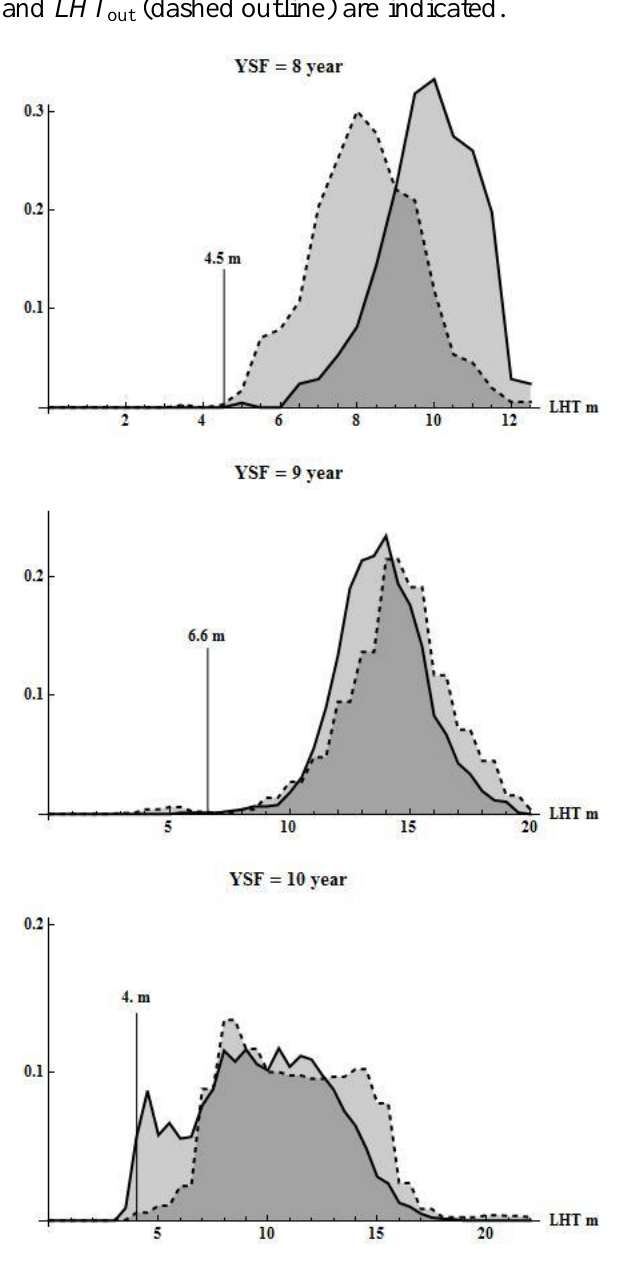
Figure 7. Three randomly selected examples (of 32) without an identified post-fire recovered canopy. The assigned default canopy height is indicated. The distributions of LHT (full outline) and LHT (dashed outline) are in out